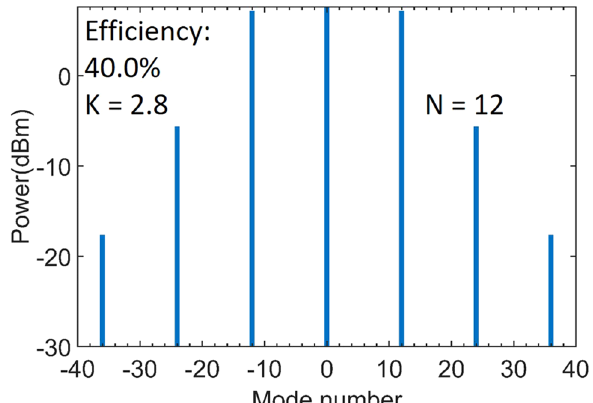
Figure 7. Comb spectra with 40% efficiency for detuning = + 0.003, input power = 28 mW, and coupling factor K =